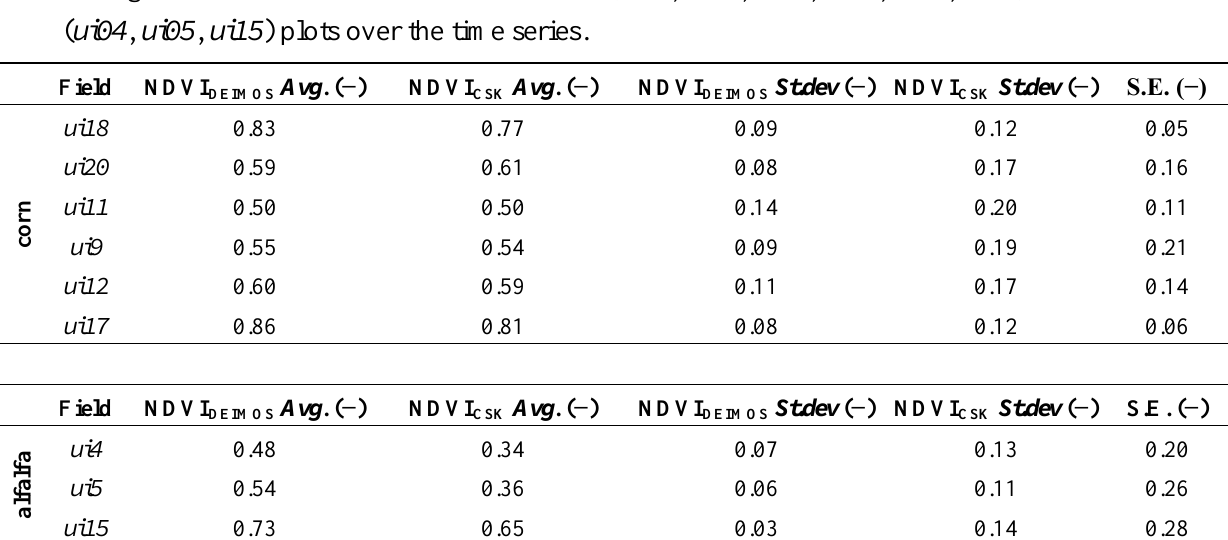
Table 2. Comparison between NDVI and NDVI: field temporal average, temporal CSK average st.dev and S.E. calculated over corn ( ui09 , ui11 , ui12 , ui17 , ui18 , ui20 ) and alfalfa ( ui04 , ui05 , ui15 ) plots over the time series.